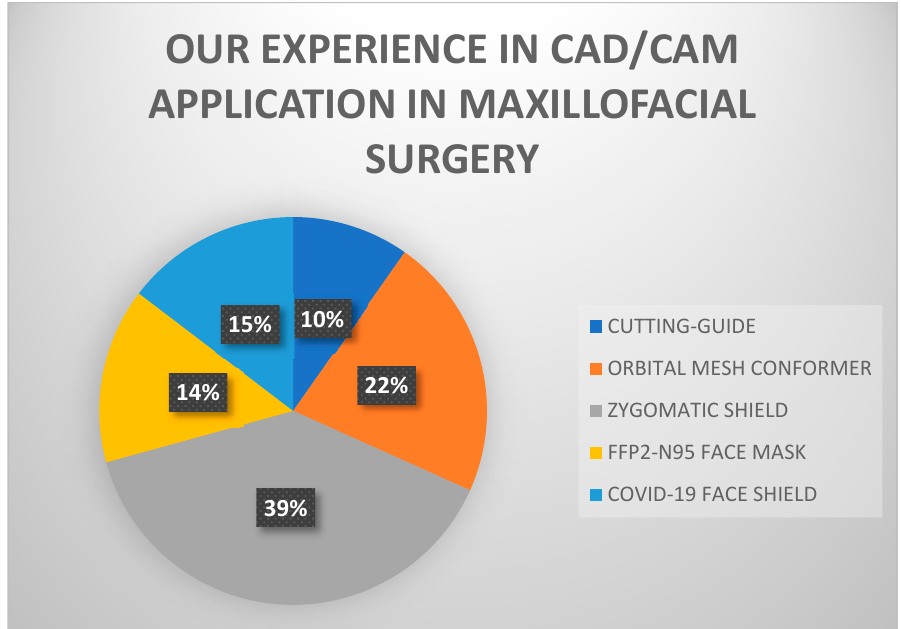
Figure 1: Graphical representation of our cases. Figure 1. Graphical representation of our cases.